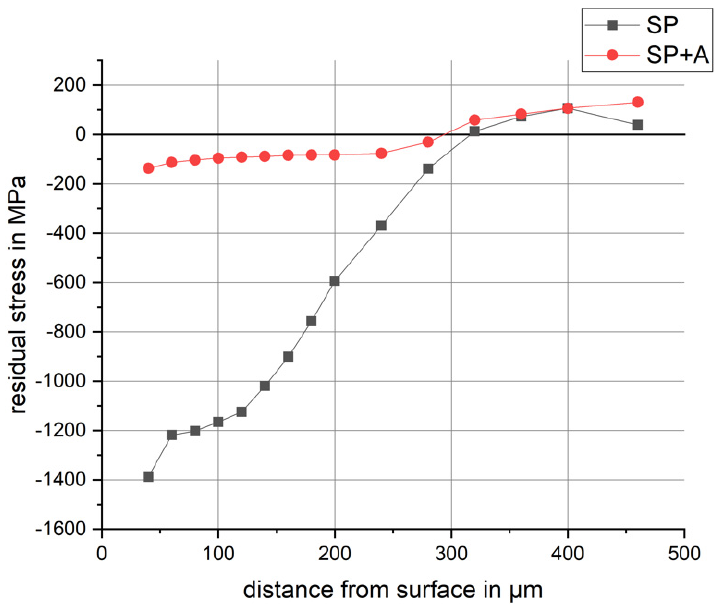
Figure 5. Residual stress depth distributions for the SP and SP+A samples determined using the incremental hole-drilling method.